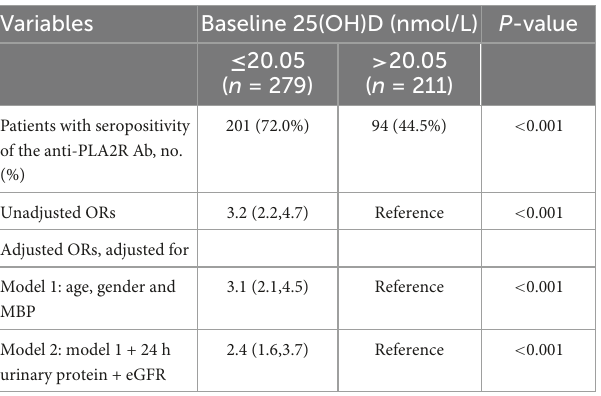
Oddsratio(OR)and95%confidenceintervalswerederivedfromlogisticregressionanalyses. Model1:unadjusted.Model2:adjustedforage,gender,andMBP.Model3:Model2plus24-h urinary protein and eGFR. Anti-PLA2R Ab, anti-phospholipase A2 receptor antibody; MBP, mean blood pressure; eGFR, estimated glomerular filtration rate. A two-tailed P < 0.05 was consideredstatisticallysignificant.